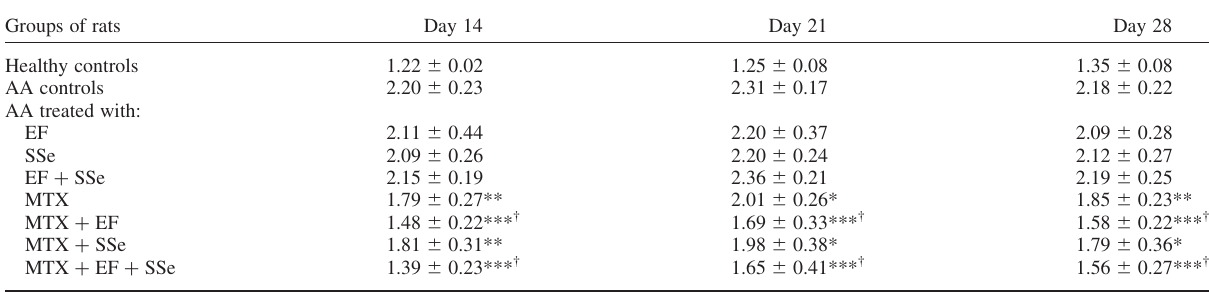
Data represent mean values ^ SD for 10 rats. Significantly different from arthritic control rats: * p , 0 : 05 ; ** p , 0 : 01 ; *** p , 0 : 001 : Significantly different from arthritic rats treated with MTX alone: † p , 0 : 05